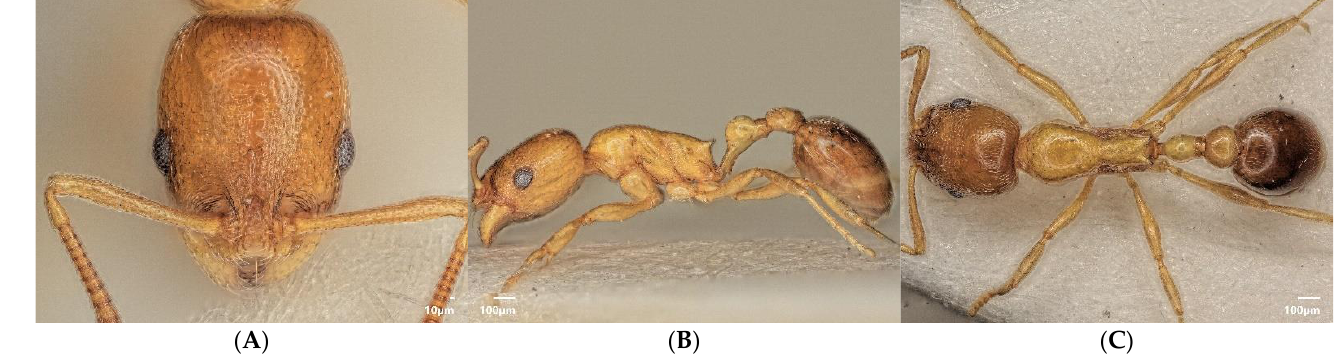
Figure 8. Cardiocondyla britteni, holotype (specimen CASENT0901496 from www.antweb.org, photo Ryan Perry): head in dorsal view ( A ), lateral view ( B ), dorsal view ( C ).